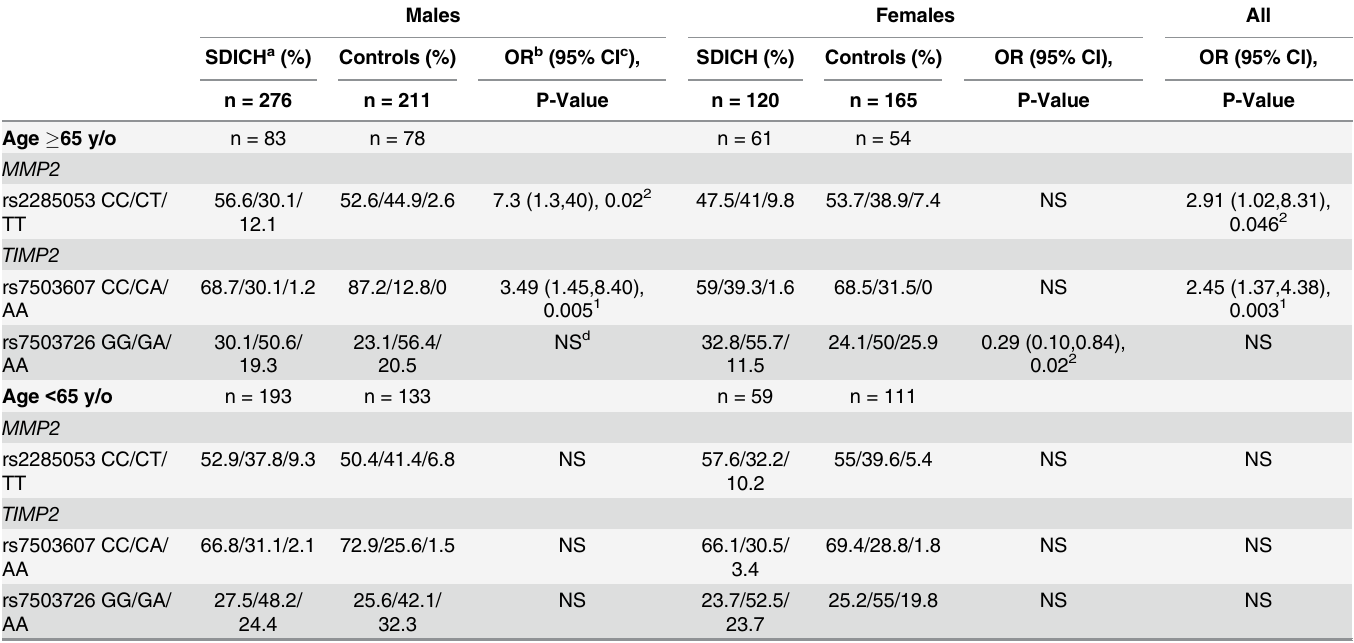
Table 2. Frequencies and associations of the genotypes in patients with spontaneous deep intracerebral hemorrhage and